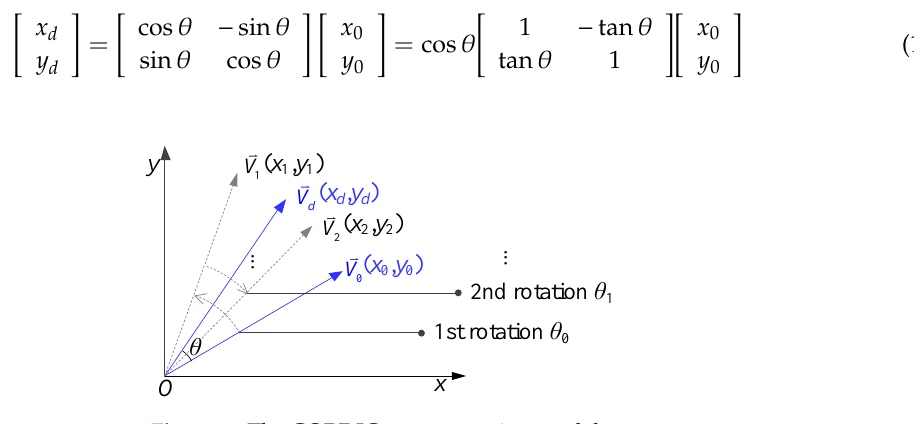
Figure 1. The CORDIC vector rotation model.